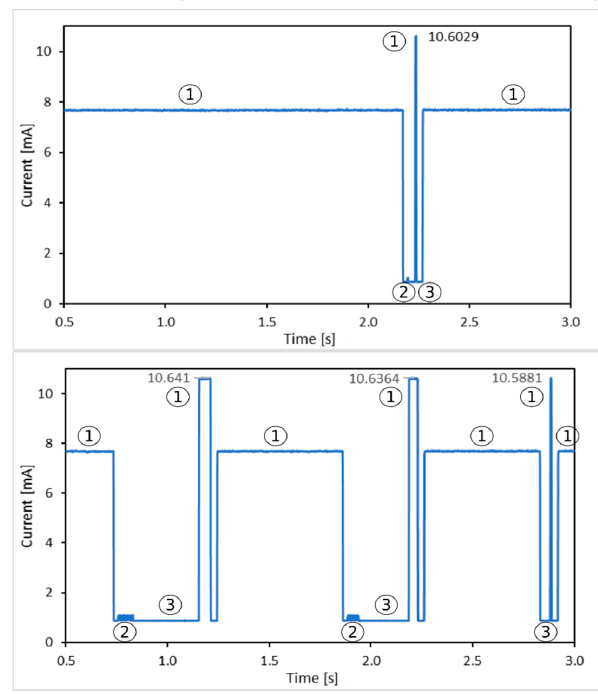
Figure 9. Current associated to reception mode at 4.2 V in the supercapacitor for the command read one datum in the upper graphic and read all data in the lower graphic. The transceiver is in reception mode for this test. As in the previous image, the numbers represent which element is the one that has the largest contribution to the consumption of the tag in that interval in each case: 1 is for transceiver, 2 is for the EEPROM and 3 is for the microcontroller. The upper graphic shows the reception of one datum and the confirmation of the transmission, the datum read is the last saved in EEPROM. In the lower graphic, the reception of all possible data and transmission confirmation are shown. The number 2 reflects the EEPROM aggregated consumption and the number 3 is the peak for the transceiver transmission.